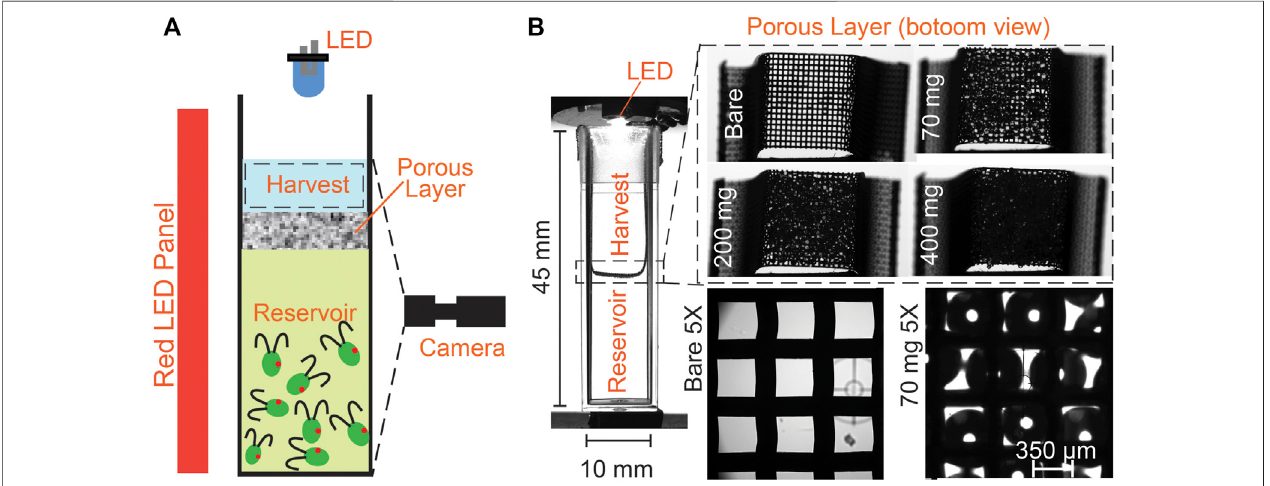
FIGURE 1 | Schematic showing lower reservoir and upper harvest regions, separated by a wire mesh overlaid with beads: the porous layer. (A) A blue LED is mountedonthetopofthecuvettetocreateaphototacticbias.Forimagingthesuspensionandconcentrationcalibration,adeepredLEDilluminatesthecuvettefromthe side (deep red light does not elicit phototaxis [3]). (B) Glass beads of diameter 425 − 600 μ m were used to create the porous layer. 70 mg of bead results in single layer, 200 mg – 2 to 3 layers, and 400 mg – 4 to 5 layers, respectively.